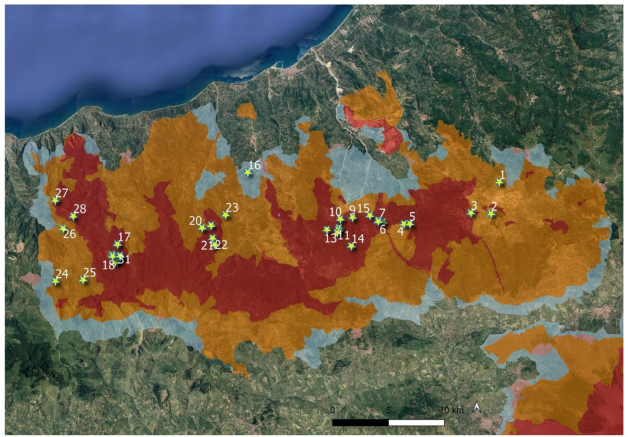
Figure 7. Wetlands investigated in Nebrodi Mounts (localities are given in Table S1), with zonation of the regional park (zone A: red; zone B: orange; zone C: blue; zone A is the most protected